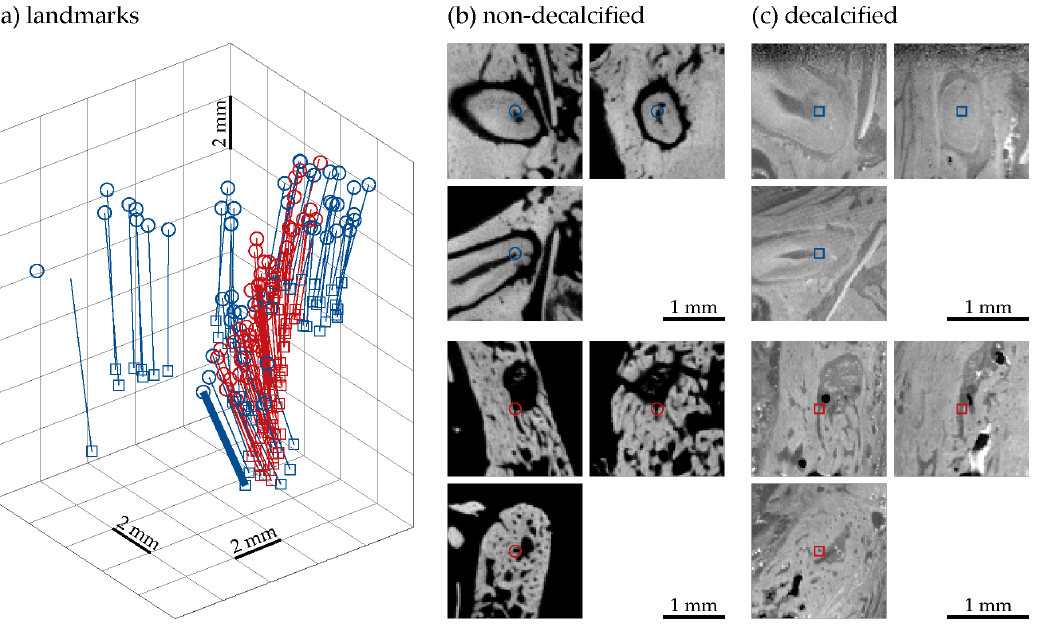
Figure 4. ( a ) Spatial distribution of corresponding landmark pairs, with landmarks LM1 used for registration (shown in blue) and landmarks LM2 for determining registration accuracy (shown in red). Lines connect the manually selected landmark positions in the decalcified tissue (marked by a rectangle) with the corresponding position in the non-decalcified tissue — as determined by non-rigid image registration. This can be compared to the manually selected landmark position marked by circles. ( b , c ) Orthogonal slices at the manually selected landmark pairs are marked with thick lines in ( a ). These are at point features within (top) a tooth and (bottom) a lacuna in newly formed bone.